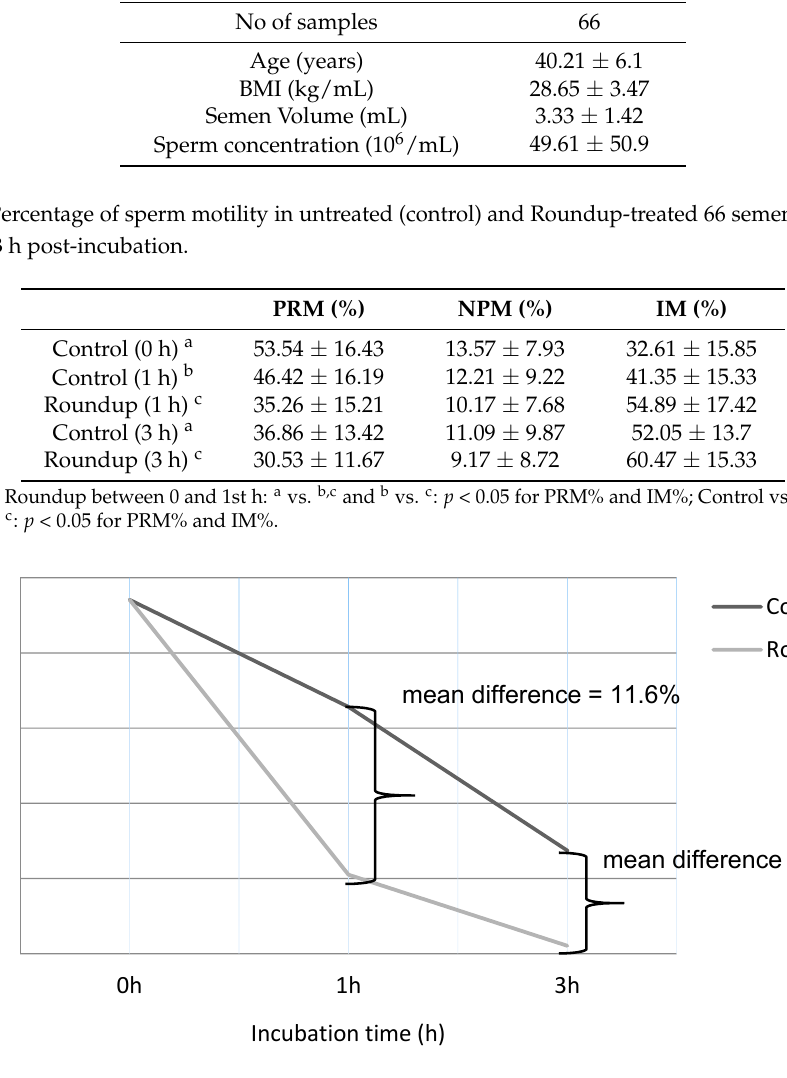
Figure 1. Schematic presentation of the percentage (%) of the progressive motility (PRM) between untreated (control) and the herbicide-(Roundup-) treated sperm samples. After 1 h of exposure to the Roundup, an approximately 11.16% reduction in motility was observed compared to control cells, whereas after 3 h incubation an approximately 6.33% decrease was observed, compared to controls (11.16% vs. 6.33%, p < 0.05).